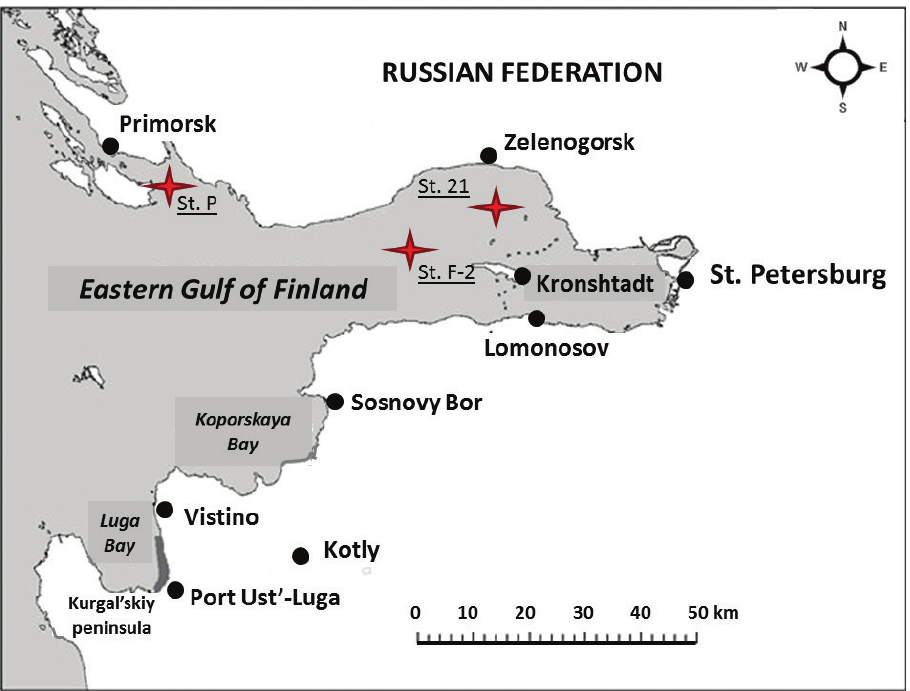
Figure 1. Scheme of the eastern Gulf of Finland (the Baltic Sea) showing the location of sampling stations: St. P, St. F-2 and St. 21